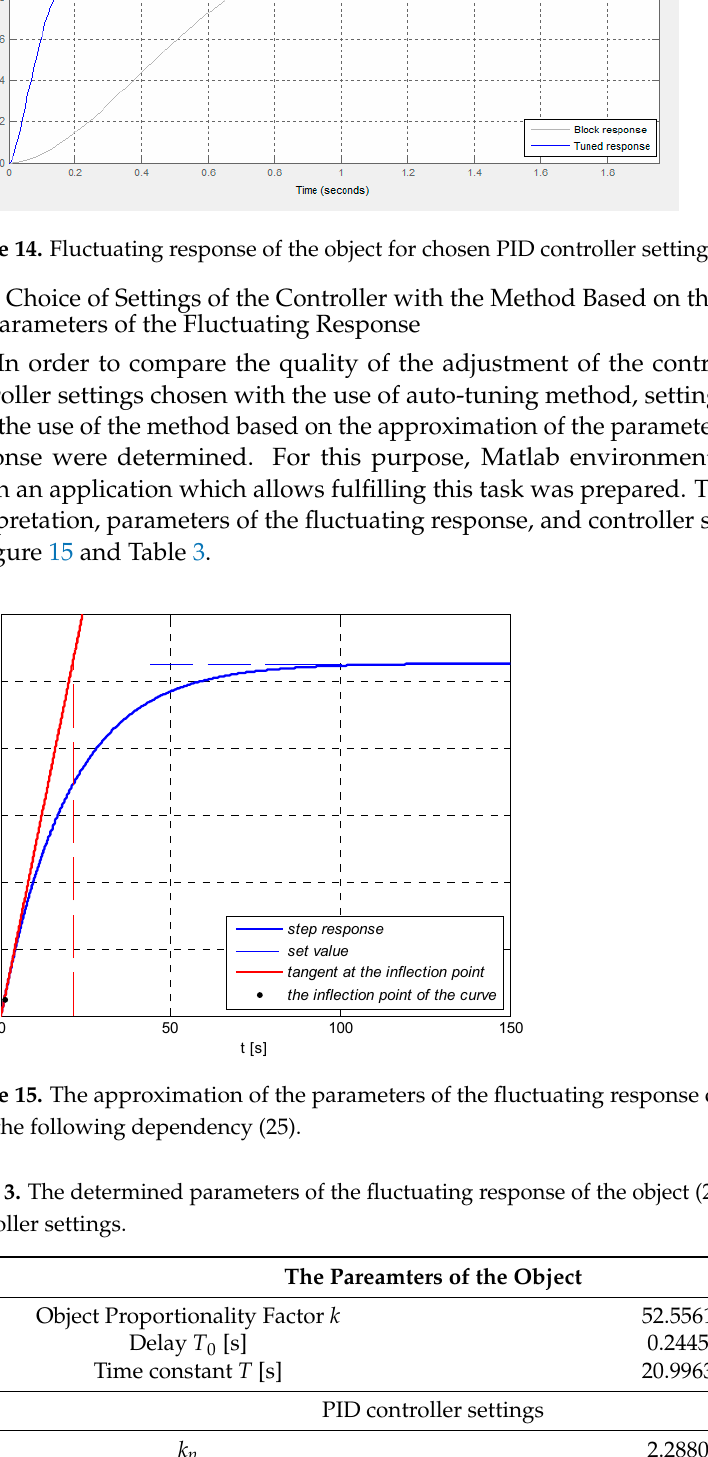
Figure 14. Fluctuating response of the object for chosen PID controller settings. Table 2. PID regulator settings chosen with the auto-tuning method in Matlab/Simulink.